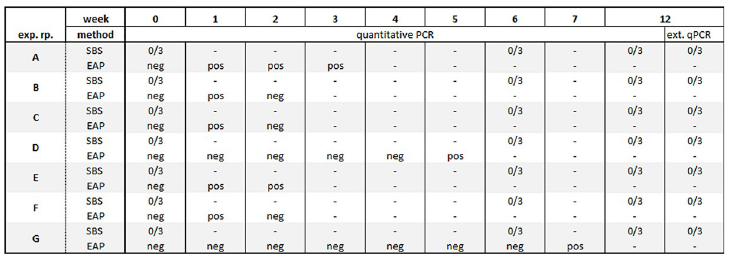
Fig 3. Comparison of qPCR results for soiled-bedding sentinels (SBS) and Exhaust Air Particle (EAP) monitoring at known M . musculinus prevalence. M . musculinus = Myocoptes musculinus; Exp. rp. = Experimental repetition; SBS = Soiled bedding sentinels; EAP = Exhaust air particle; ext. qPCR = quantitative PCR performed at an external provider; pos = positive EAP qPCR result for M . musculinus ; neg = negative EAP qPCR result for M . musculinus ; numerals = number of positive Sentinels per number sentinels tested for M . musculinus qPCR or serology dash, not tested; asterisk, samples between 0–1 copy / μ L.